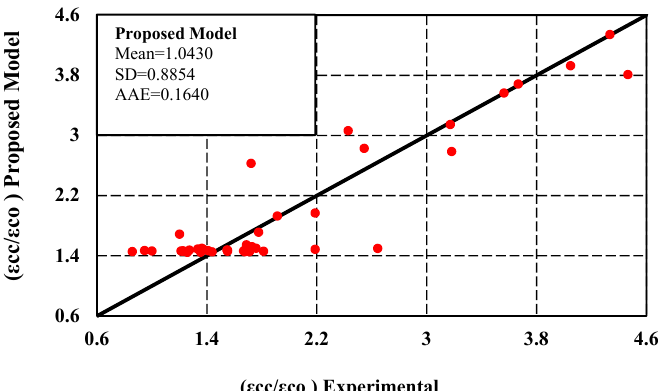
Figure 10. Comparison of ε cc ε co values obtained from the proposed model (Equation (15e)) and experimental